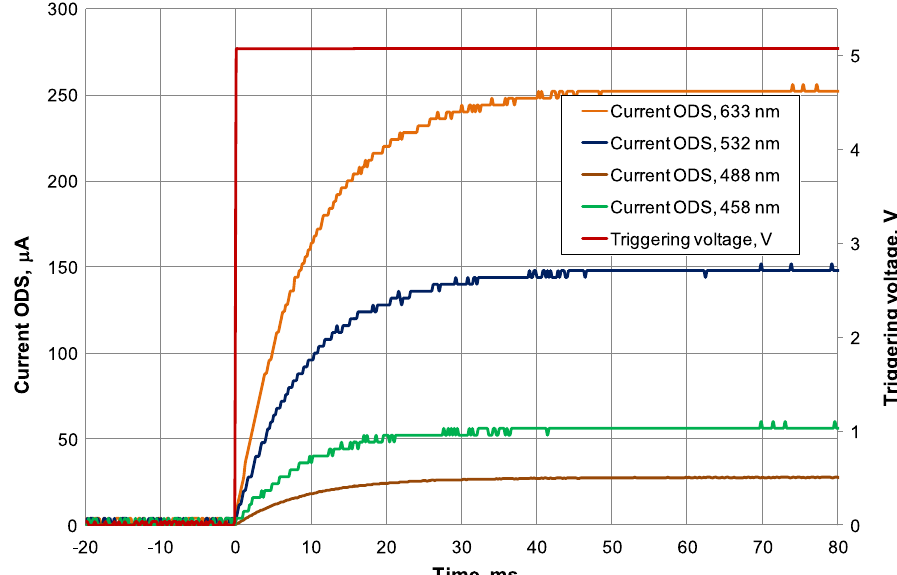
Fig. 7. Time-resolved spectrally fi ltered optical signal of the DC-driven CoB (ID VSL096). Triggering electrical forward voltage is shown in red for